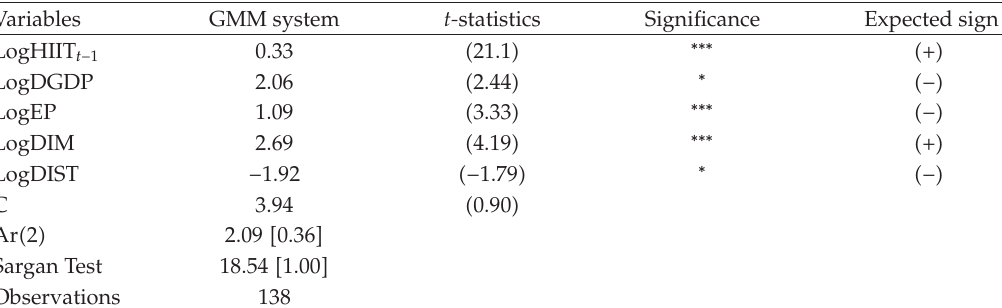
Table 4: Determinants of Horizontal Intraindustry